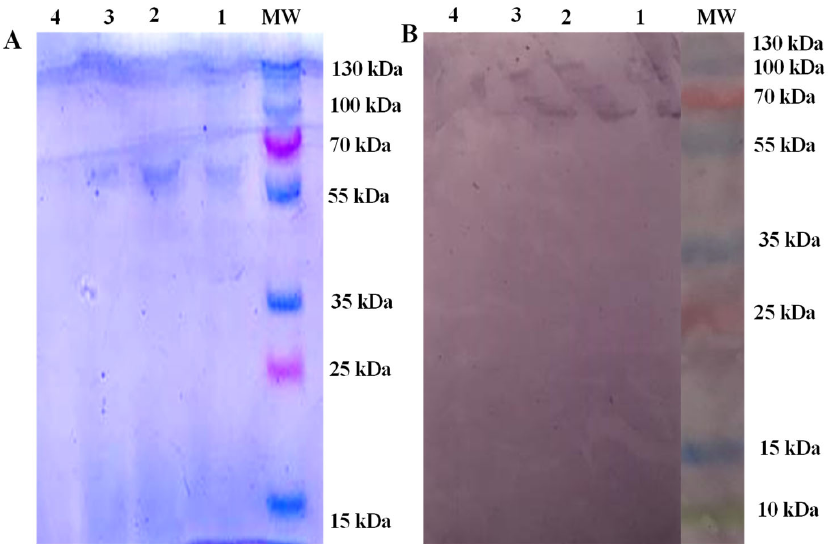
Figure 1. ( A ) Coomassie ‐ blue ‐ stained SDS ‐ PAGE showing protein separation and identification of